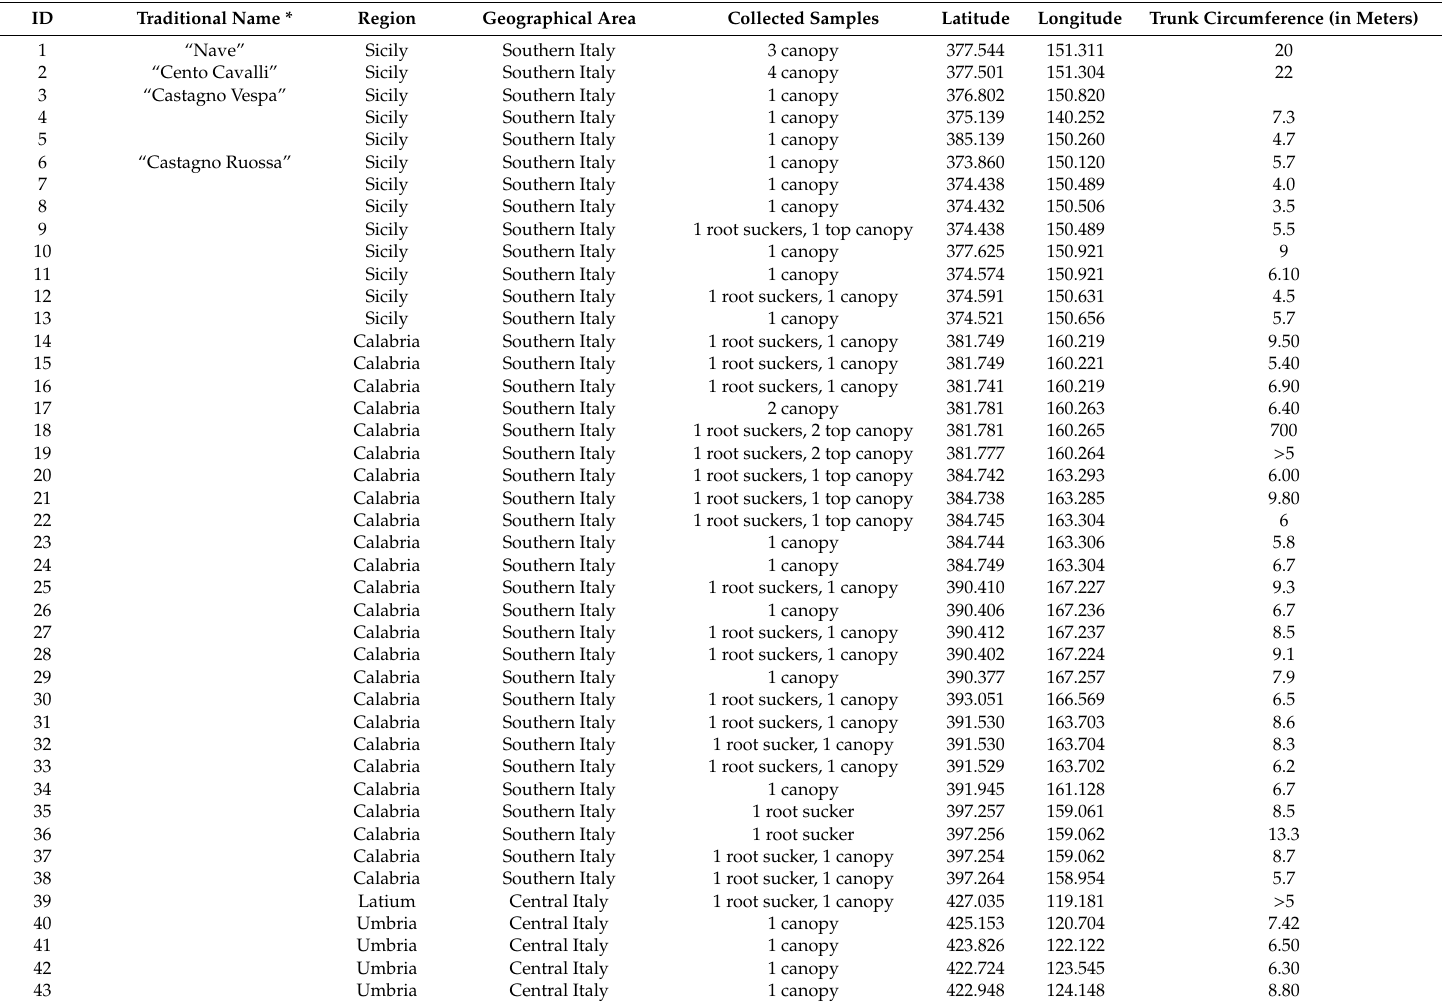
Table 1. Large old chestnuts analyzed in this